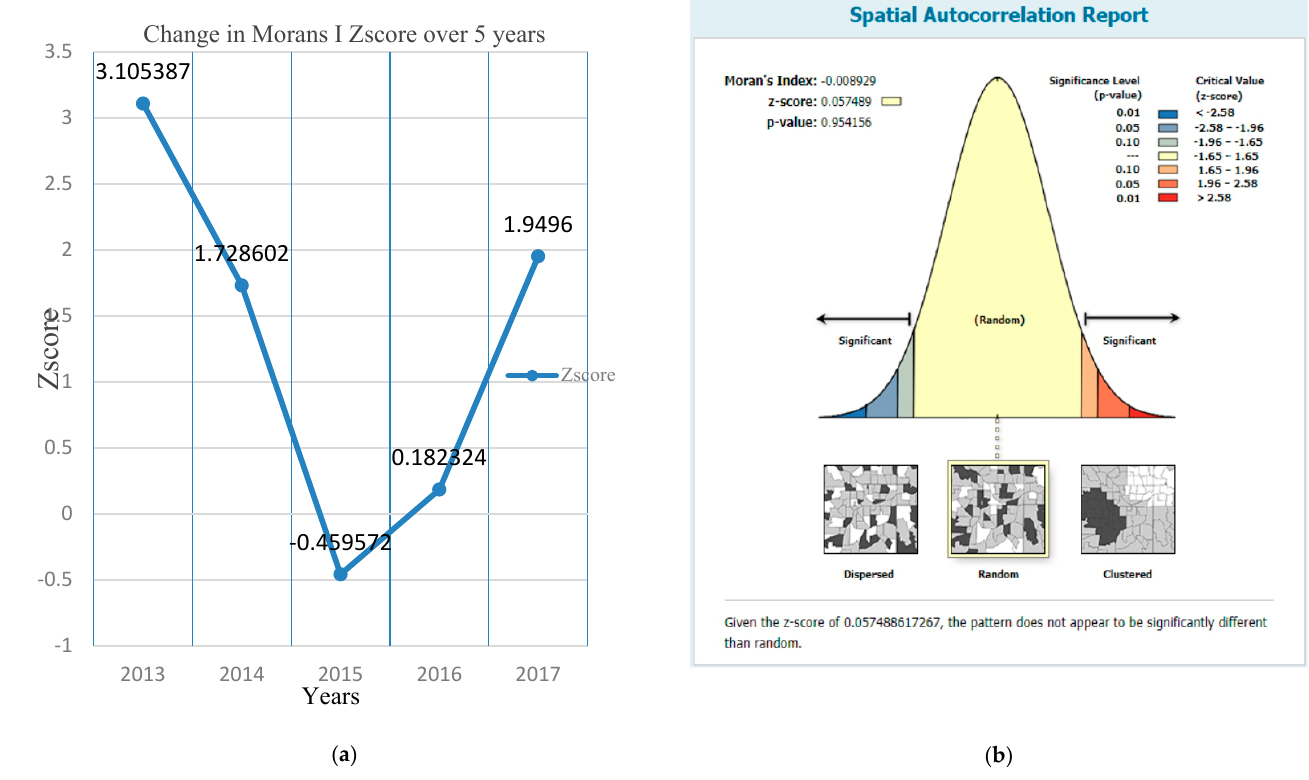
Figure 3. Line chart of Z -scores and the Moran’s I total accidents report. ( a ) Change in Moran’s I Z -score between 2013 and 2017; ( b ) Report of Moran’s I : The total accidents for the 5 years.